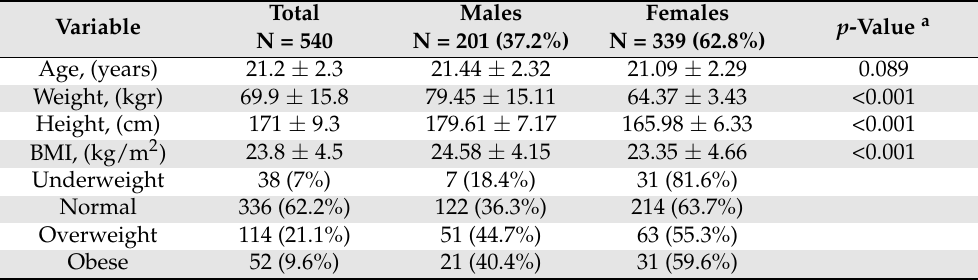
Table 1. Demographic characteristics of the study population.